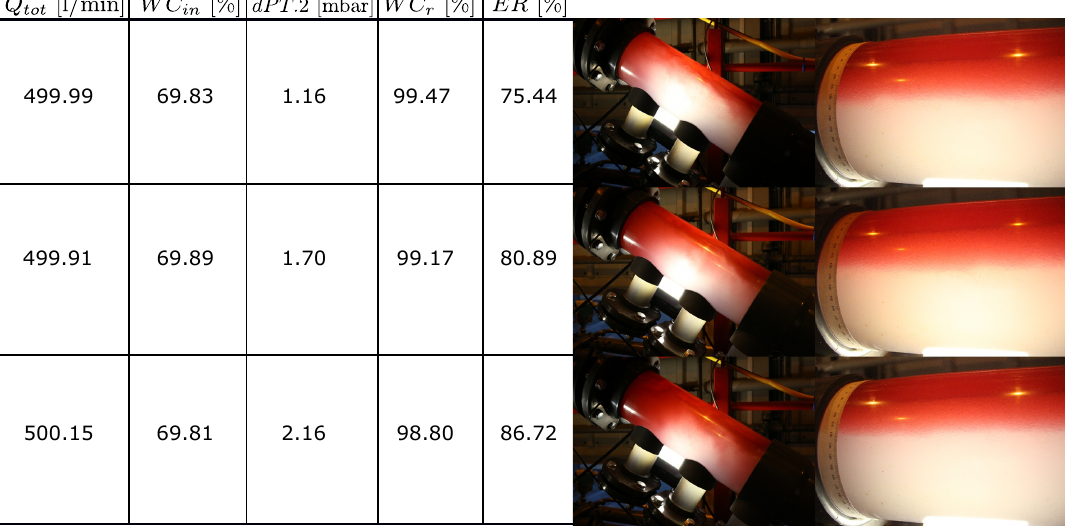
Figure A4. 500 L/min inlet flow and 70% water